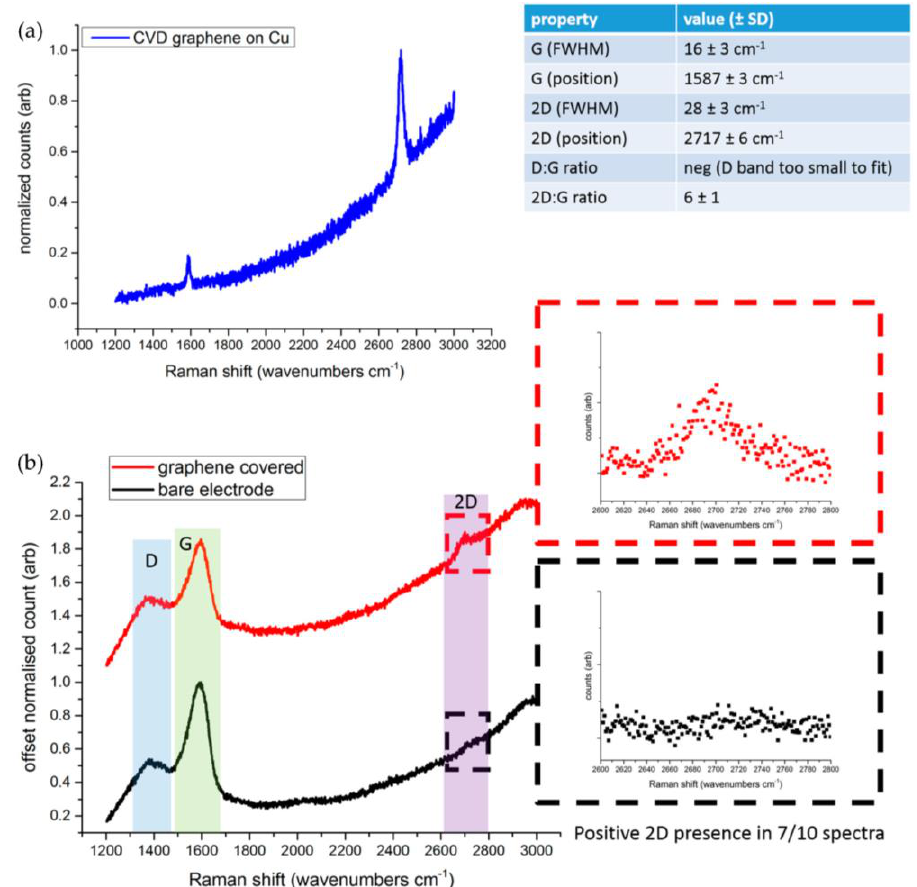
Figure 3. Raman analysis of graphene (GN) and bare Ag/AgCl electrode. ( a ) Raman spectrum of graphene grown on Cu after chemical vapour deposition (CVD); and ( b ) Raman spectrum for the GN-coated electrode and conventional Ag/AgCl bare electrode.